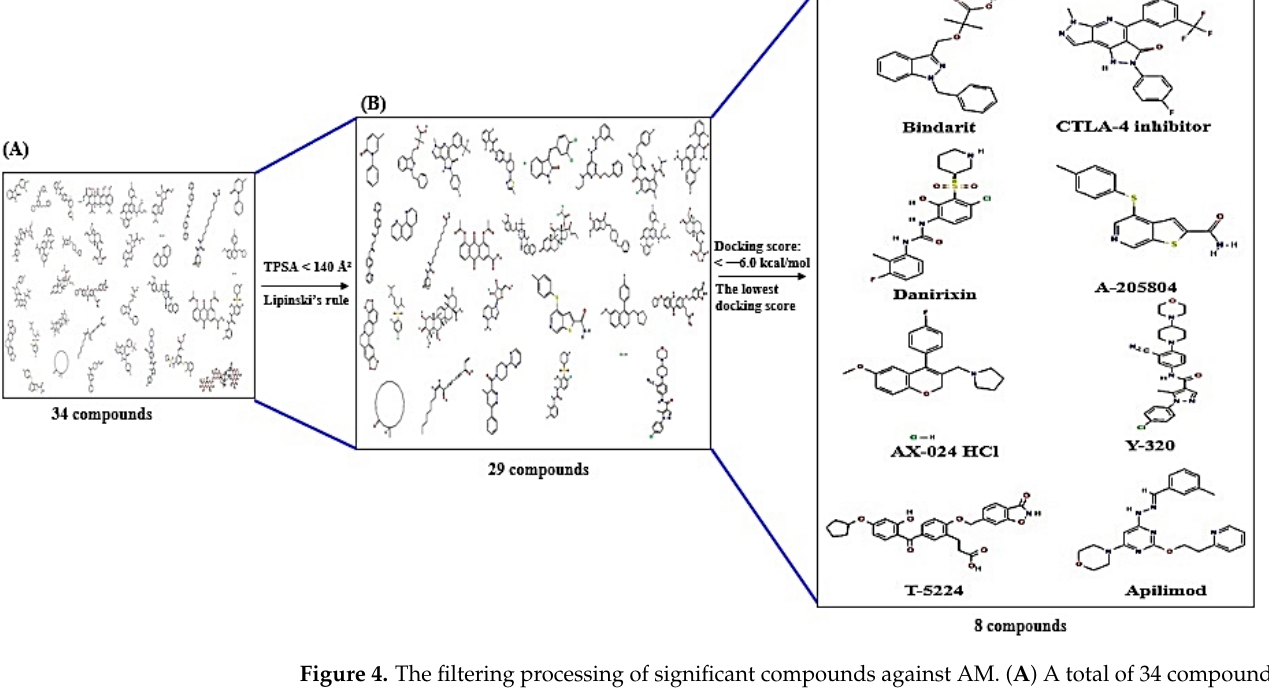
− 6.2 kcal/mol on IL2 (PDB ID: 1M47) (Figure 5H). The MDT confirmed the stable binding between eight core ligands as well as eight targets (Table 3).